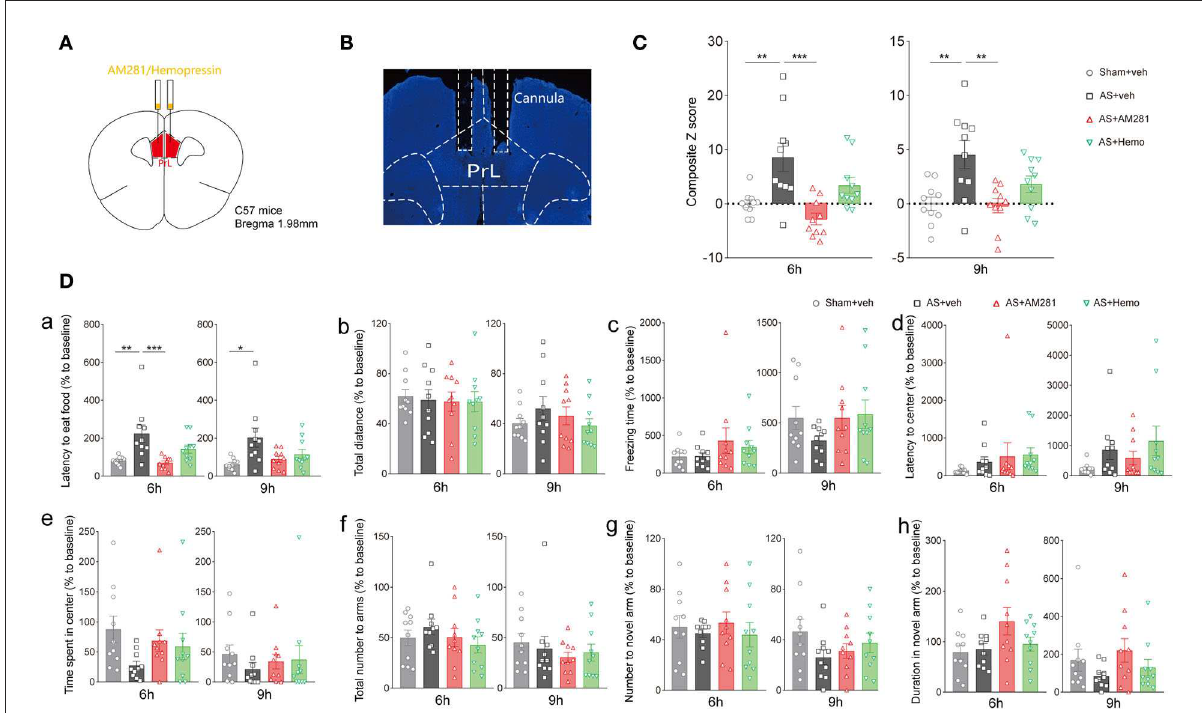
FIGURE3 Blockade of CB1R in the PrL promoted the composite Z score. (A) Scheme of the drug administration. (B) The site of the cannula in the PrL. (C) The composite Z score at 6h (left) and 9h (right) after AS. (D) The latency to eat food in buried food test (a); the total distance (b), the freezing time (c), the latency to center (d), time spent in center (e) in the open field; the total number to arm (f), number to novel arm (g), duration in the novel arm (h) in Y maze at 6h (left) and 9h (right) after AS. Data are shown as mean ± SEM. N = 10. * P < 0.05, ** P < 0.01, *** P < 0.001. ISO, isoflurane; AS, anesthesia and surgery; Hemo,